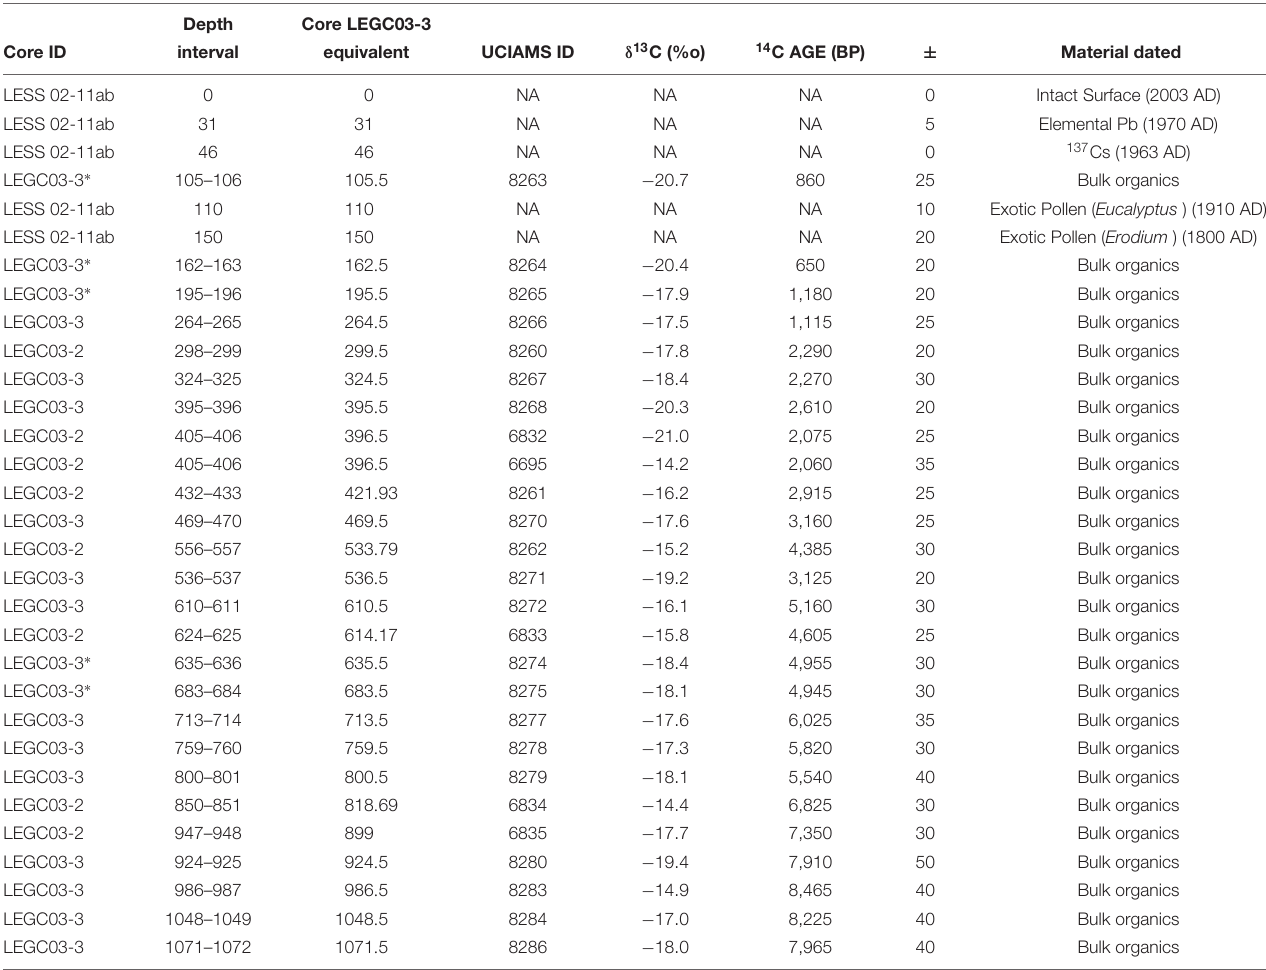
TABLE 1 | LEGC03-2 and 3 and LESS02-11 age control data.